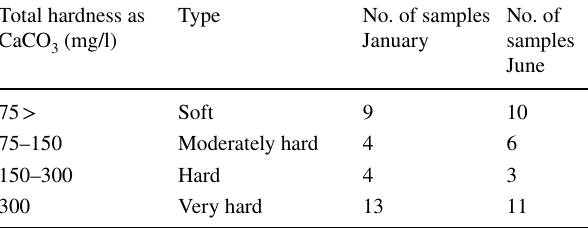
Table 3 Sawyer and McCarty’s (1967) classification based on hard- ness Total hardness as CaCO 3 (mg/l)